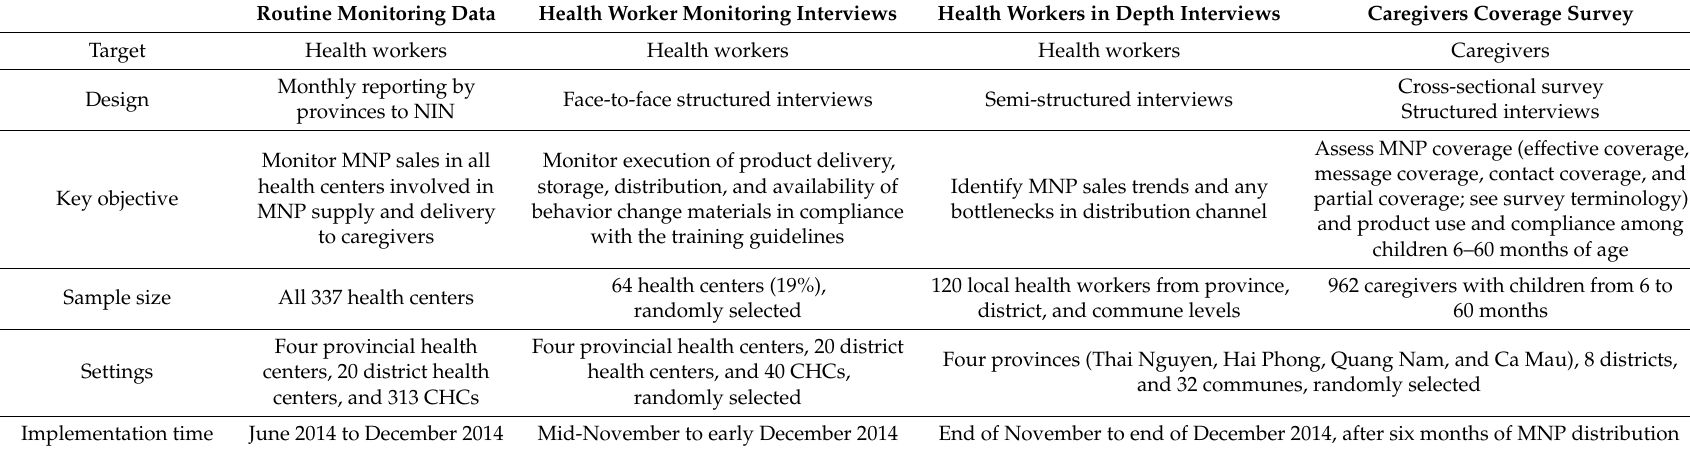
Table 2. Summary of monitoring and evaluation design, sampling size, and implementation